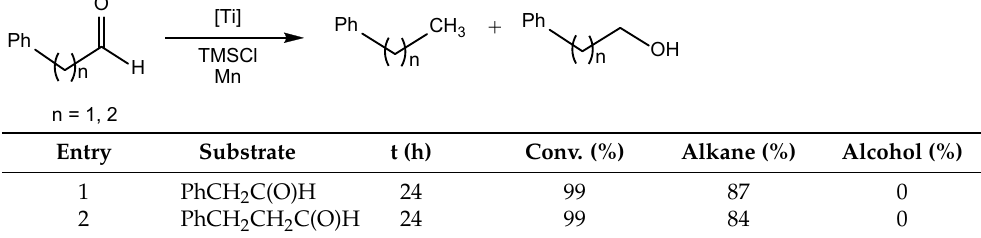
Table 2. Substrate scope using 4 as the catalyst a,b .